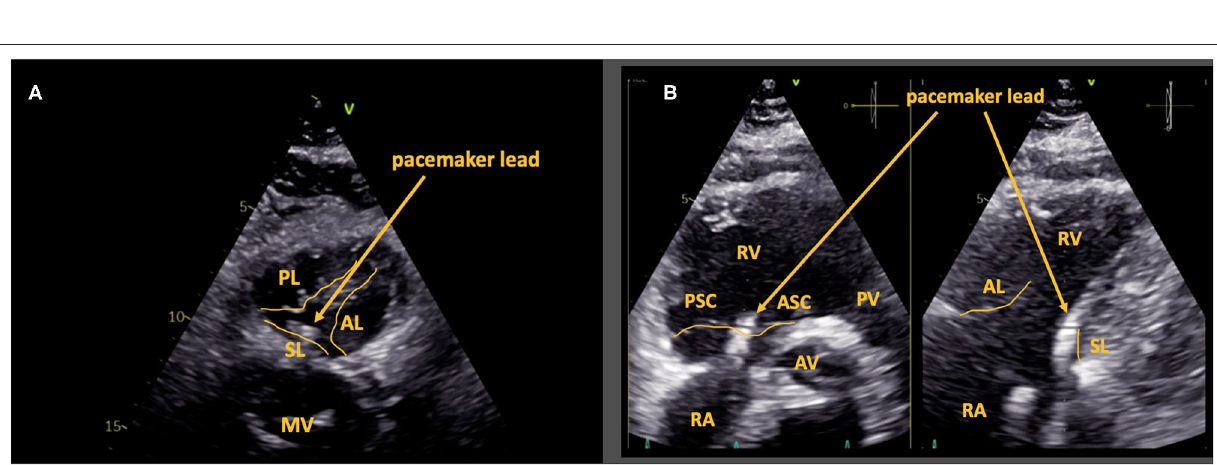
FIGURE 1 | Determination of lead position via subcostal en face view of the tricuspid valve. (A) shows an ICD lead in the postero-septal commissure. (B) shows a pacemaker lead in the anteroseptal commissure. (C) shows an ICD lead in central position. (D) shows a CRT-D lead in the posterior/anterior commissure. AL, anterior leaflet; PL, posterior leaflet; SL, septal leaflet; MV, mitral valve; RVOT, right ventricular outflow tract; AV, aortic valve; ICD, implantable cardioverter-defibrillator; CRT-D, Cardiac resynchronization therapy-defibrillator.